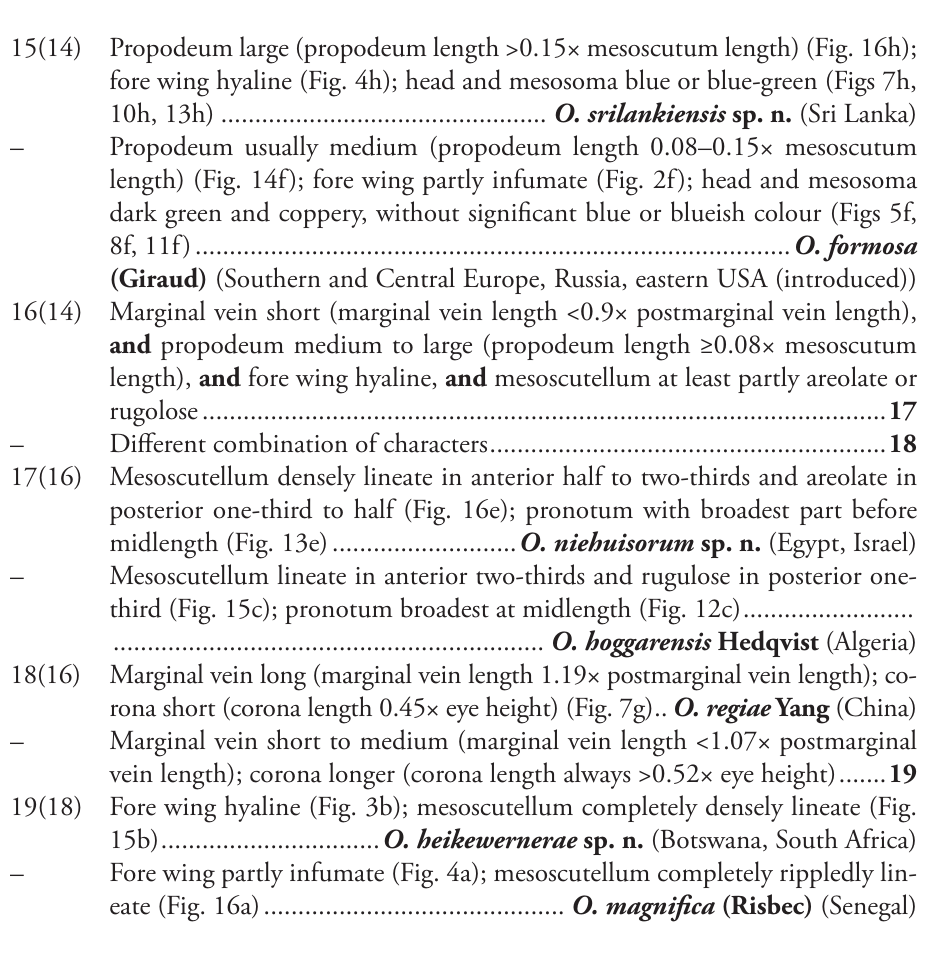
Diagnosis. FEMALE (N = 1). Medium-sized (8.40 mm). Head and mesosoma dark blue to green-blue. Fore wing hyaline. Body slender (mesonotum 1.51× as long as wide). Head round (1.41× as high as long). Eyes small (0.57× as high as head) (Fig. 8a). Corona medium (5.20× as long as wide), structure continuous (Fig. 5a). Pronotum pentagonal with posterior part distinctly narrowing towards mesoscutum, with broad- est part before midlength (Fig. 11a). Mesoscutellum normal (0.70× as long as wide), anterior margin convex (part anterior to imaginary transverse line connecting posterior margins of axillae more than 1/3 of mesoscutellum length; 0.42), mesoscutellum